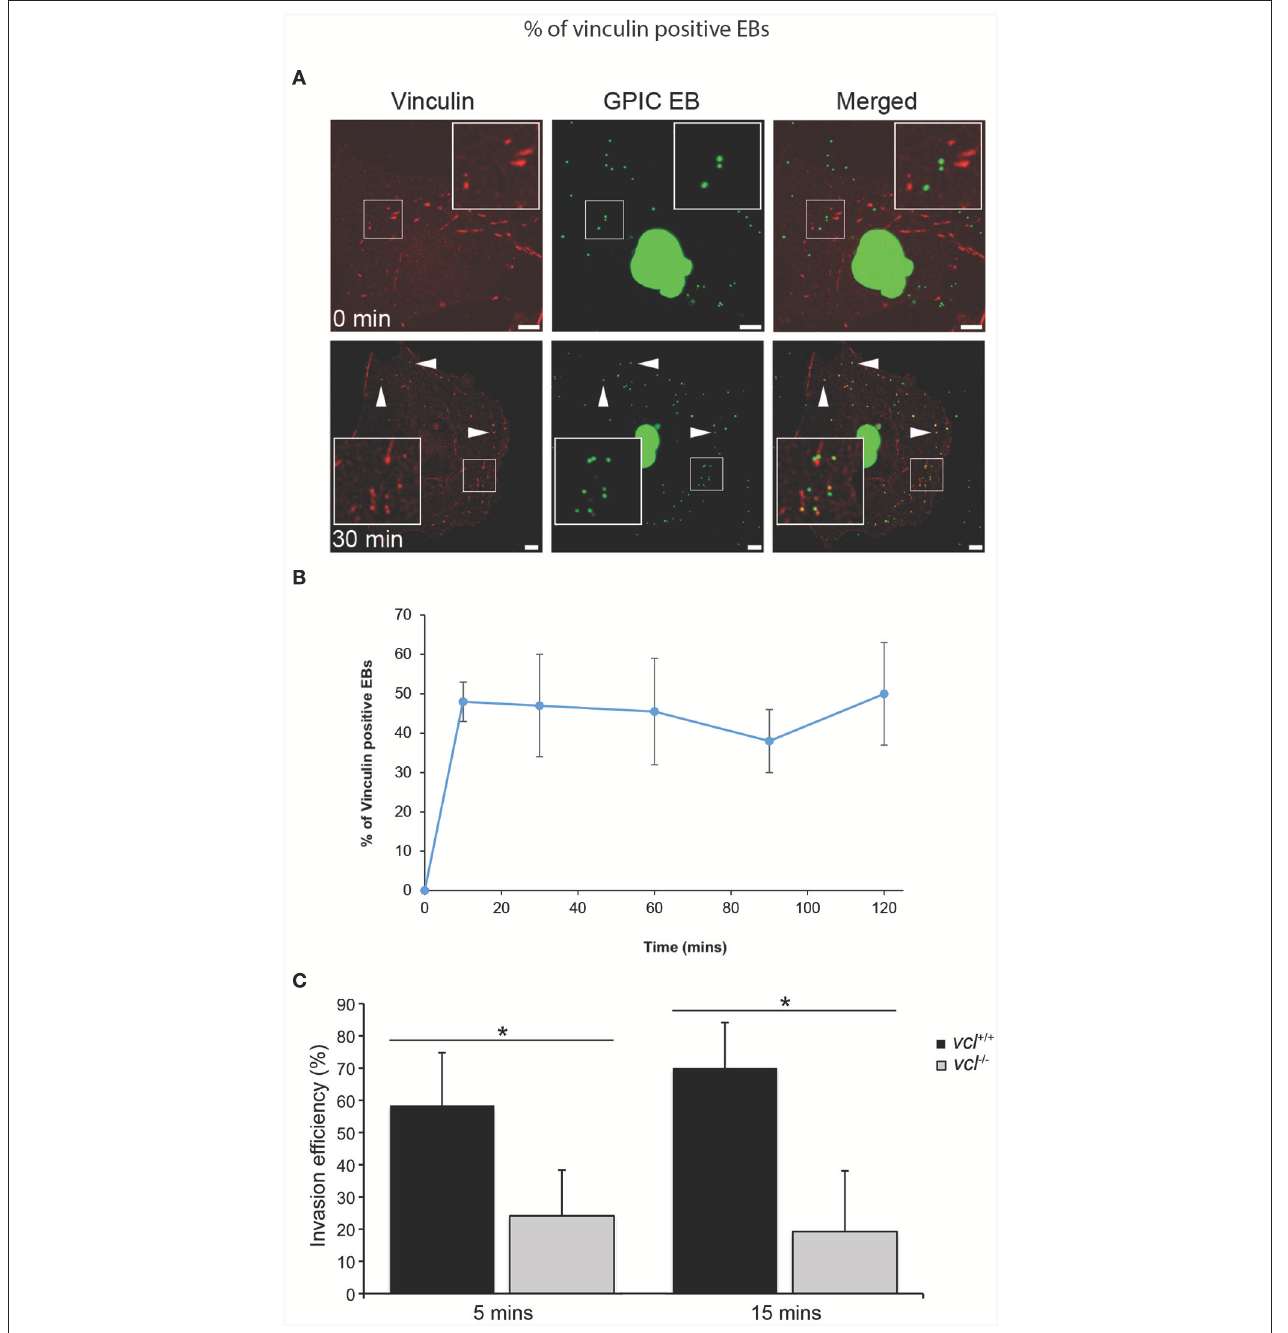
FIGURE 1 | Chlamydia recruits vinculin to sites of invasion. (A) C. caviae (GPIC) elementary bodies (EBs) were added to Cos7 cells at 4 ◦ C, and shifted to 37 ◦ C by the addition of pre-warmed media to synchronize invasion. The infection was allowed to proceed for 0, 10, 30, 60, 90, or 120min at which time the cells were fixed and process for immunofluorescence staining and microscopy. Cells were stained with an anti-vinculin antibody (red) and Chlamydiae were visualized by DAPI (green). Note the increase in the number of co-localization events from 0 to 30min. Images for the other time points are shown in Figure S1 . Scale bars: 5 µ m. White arrowheads indicate vinculin colocalizing with GPIC EBs. (B) Colocalization frequency per cell was calculated for each time point up to 120min post-infection, with at least 50 cells analyzed per time point. There is a rapid increase of vinculin recruitment by 10min p.i., which was sustained up to 120min p.i. (C) vcl + / + and vcl − / − cells were infected with C. caviae (GPIC). Infection was allowed to proceed up to 15min post-temperature shift. Cells were fixed and processed for the invasion assay as detailed in the Materials and Methods Section. GPIC invasion was evaluated in vcl + / + and vcl − / − cells. vcl − / − cells were less able than wild-type to support GPIC invasion at 5 or 15min post-infection (p.i.). Data are from a minimum of 150 cells from three independent experiments, and expressed as means ± SD. Asterisk and bar indicates statistical significance between specific groups (One-way ANOVA, Tukey’s post-hoc test, P < 0.008 ).